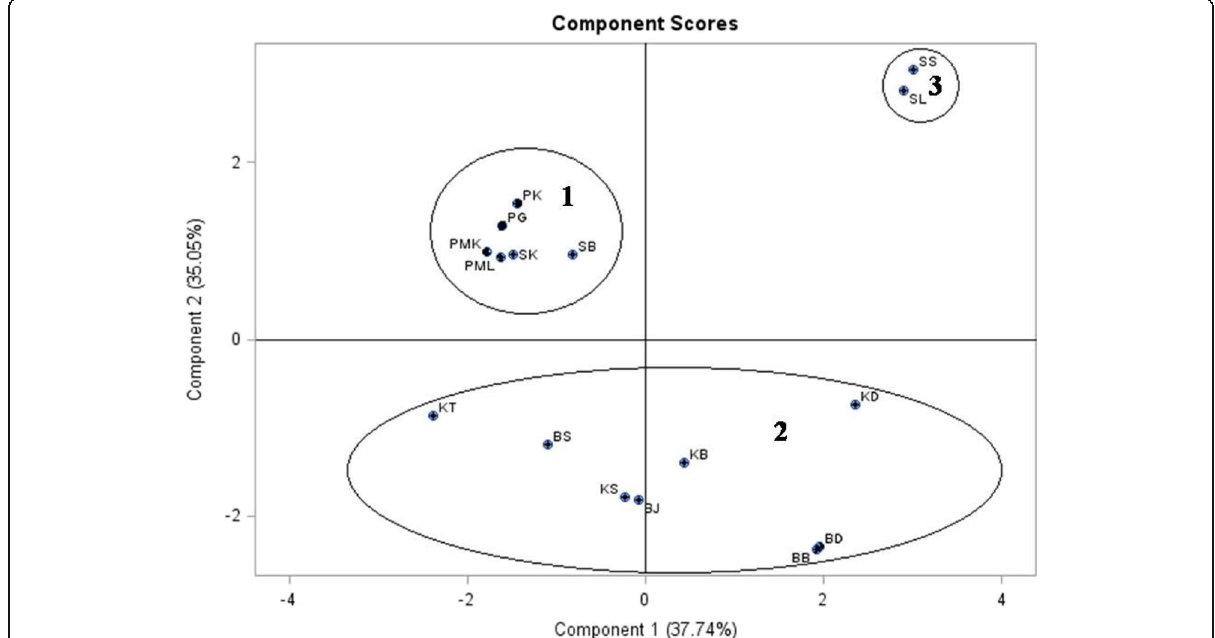
Fig. 2 Factor map for quantitative variables of different agro-climatic zones. [16 locations from four ACZs i.e. NECP (Dhuliguda-BD, Baniamari-BB, Siadimal-BS, Jamundia-BJ), NWP (Kusarimunda-SK, Badbahal-SB, Larbanga-SL, Singhpali-SS), NCP (Sirispal-KS, Baliaguda-KB, Talagaon- KT, Deogaon-